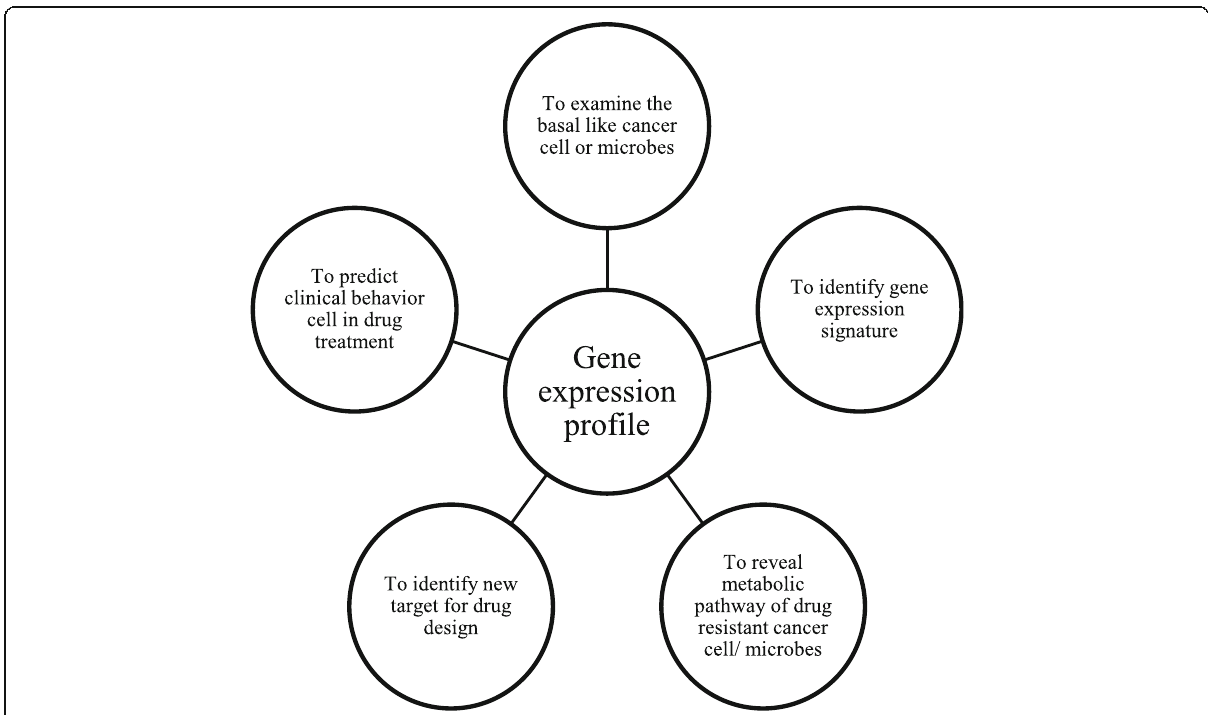
Fig. 7 Importance of gene expression profiling in drug discovery against drug